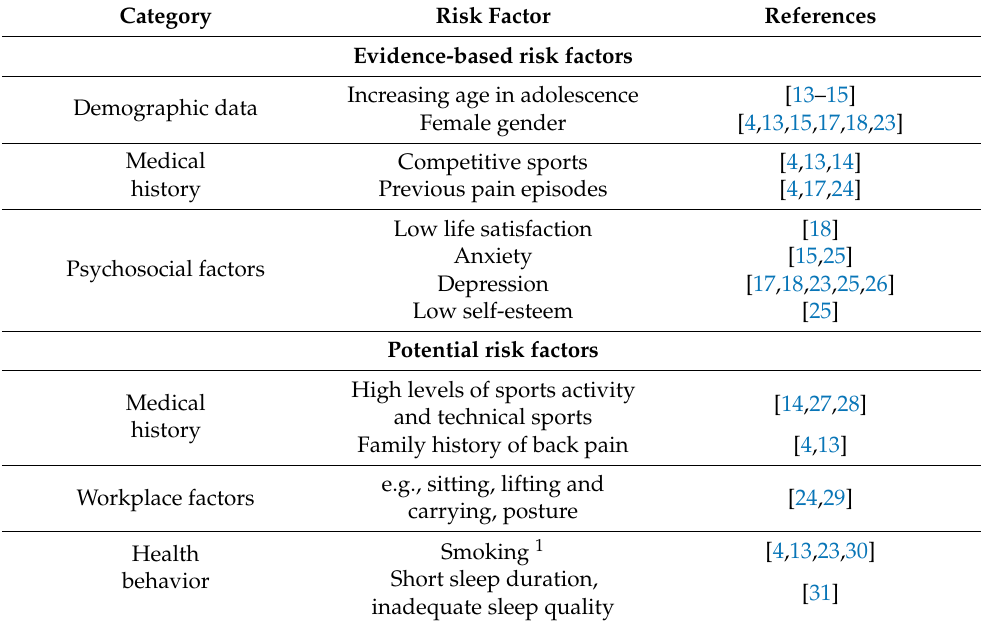
Table 2. Evidence-based and potential risk factors for non-specific back pain in children and